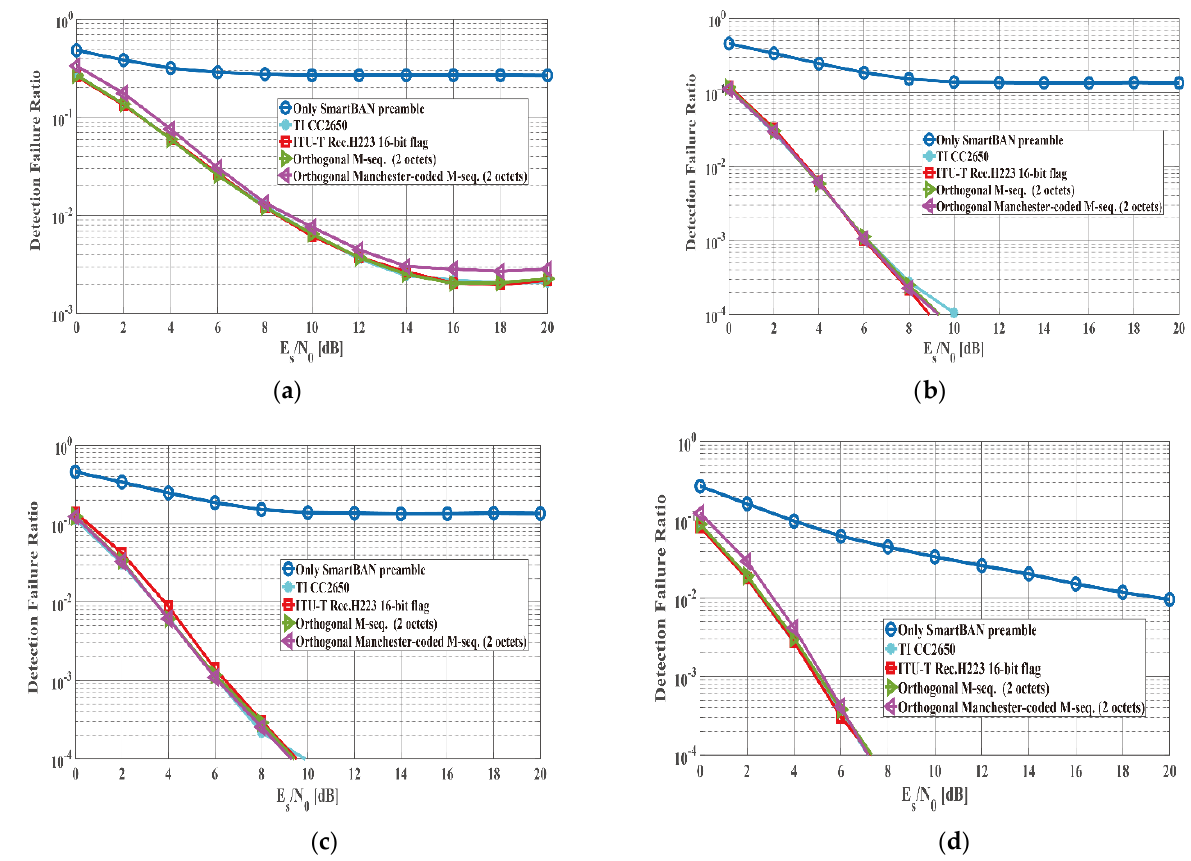
Figure 6. Physical layer convergence protocol (PLCP) header detection failure ratio in the case of several modulation schemes under the additive white Gaussian noise (AWGN) channel. ( a ) GFSK (SmartBAN) ( b ) QPSK (quadrature phase shift keying). ( c ) π /4-DQPSK (differential quadrature phase shift keying). ( d ) D8PSK.